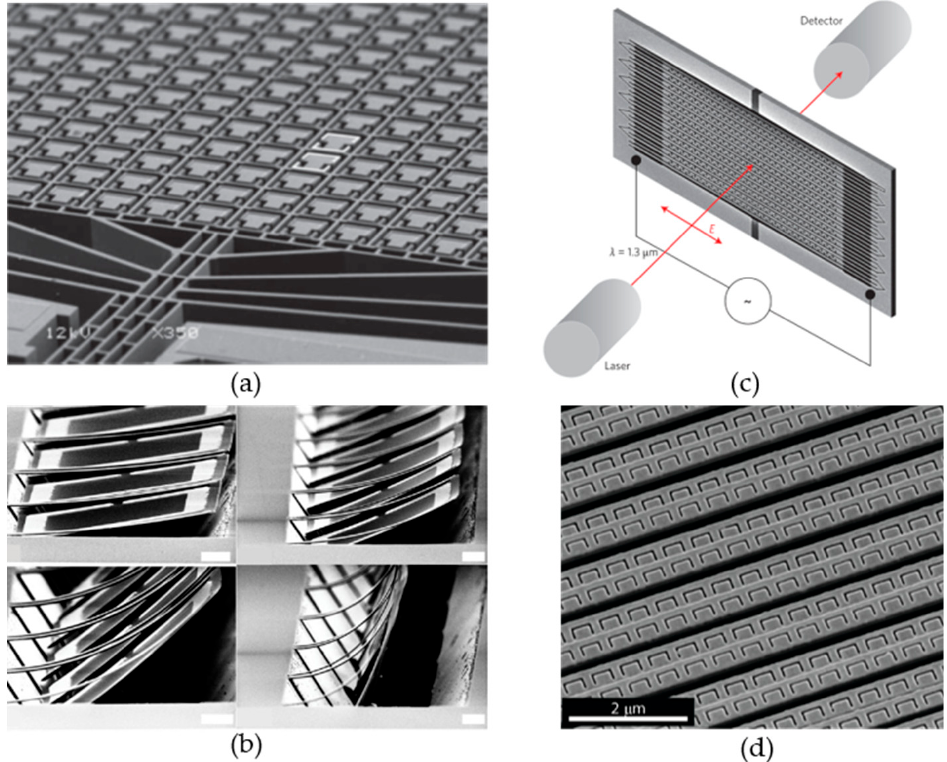
Figure 1. Microelectromechanical systems (MEMS) metasurfaces working at THz and infrared region. ( a , b ) optical switches driven by electrostatic force working at THz and infrared region, respectively; ( c , d ) amplitude modulators driven by thermo-mechanical actuation working at THz and infrared region, respectively. Figure 1a–d are reprinted with permission from [58] copyright by Wiley Online Library, 2011, [59] copyright by API Publishing, 2009, [60] copyright by Springer Nature, 2013, and [61] copyright by ACS, 2011, respectively.